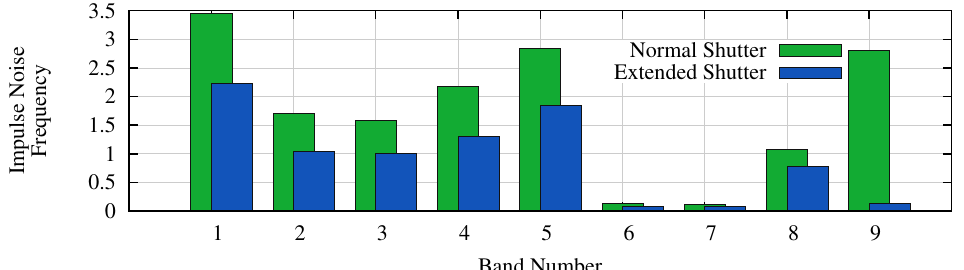
Figure 19. Impulse noise occurrences per band for the average of all normal shutter collects compared to a single extended shutter collect February